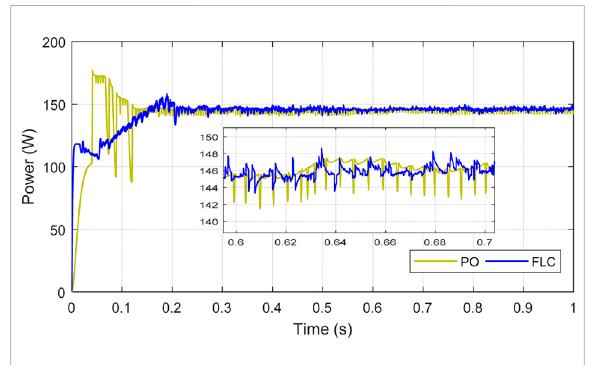
FIGURE 16 Experimental power for both FLC and P&O